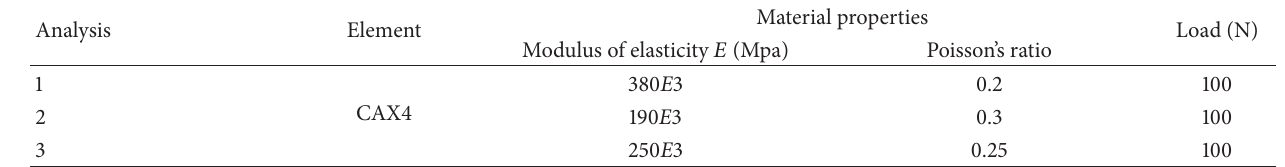
Table 1: The material property configuration and load condition for the element.